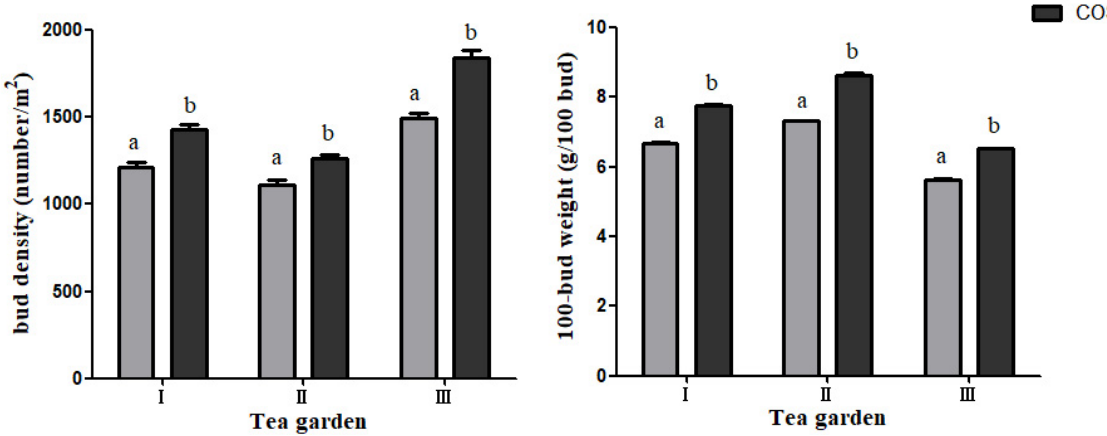
Figure 2. The effect of COS on bud density and 100-bud weight. The data represent the means ± SD of three replicates samples. Different letters indicate significant differences at p < 0.05. I, II and III represent three teagardens in Meitan County, Ziyun County, and Pingtang County, respectively.